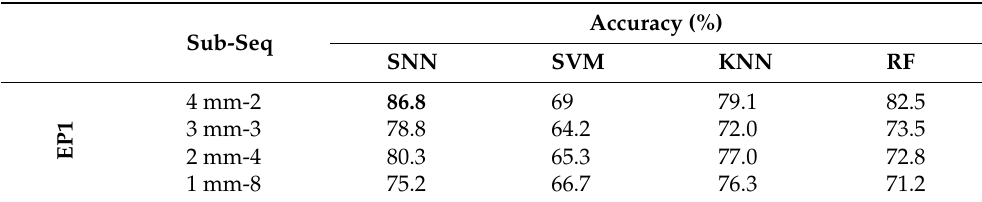
Table 1. Cross-validated multiclass accuracies for trajectory prediction using the most apical EP specific subsequences during straight path